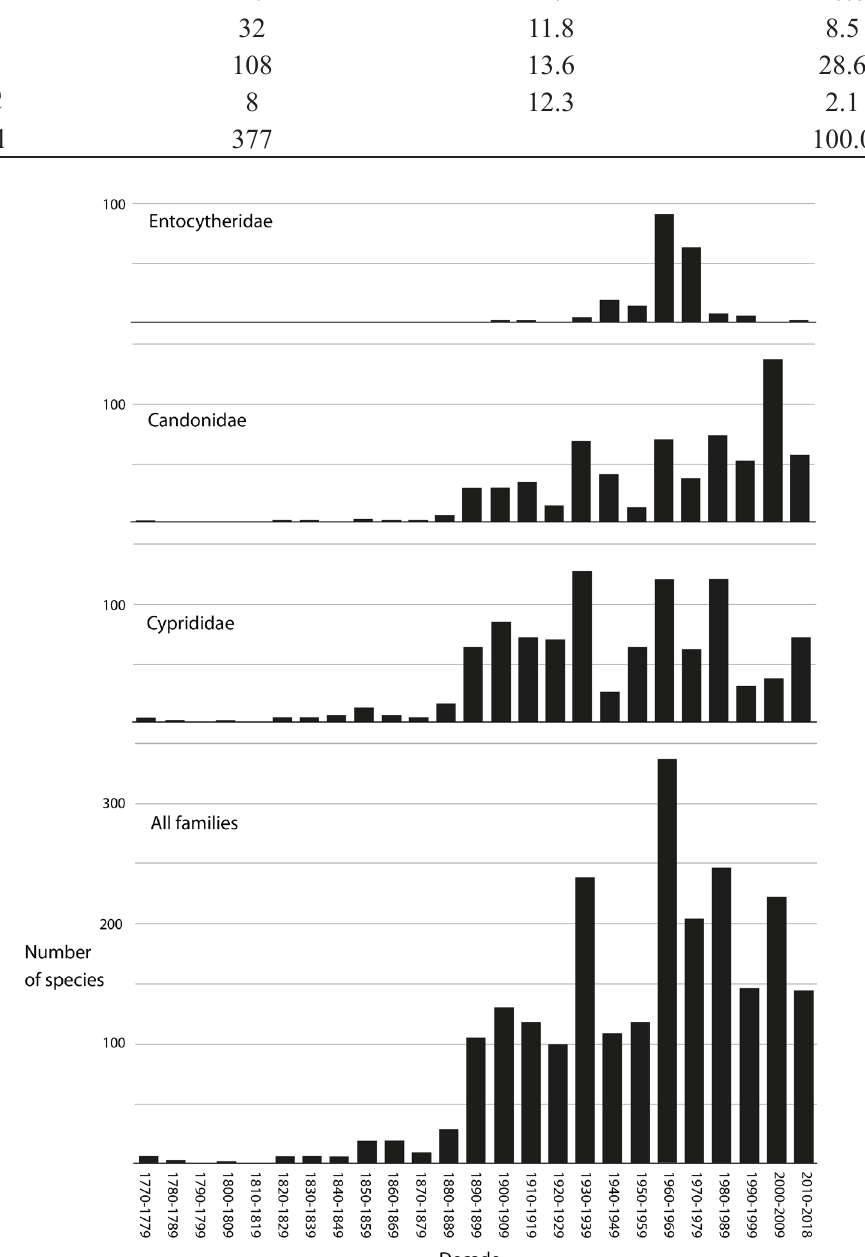
Fig. 2. Numbers of new species of non-marine ostracods described per decade for all families and the three largest families.